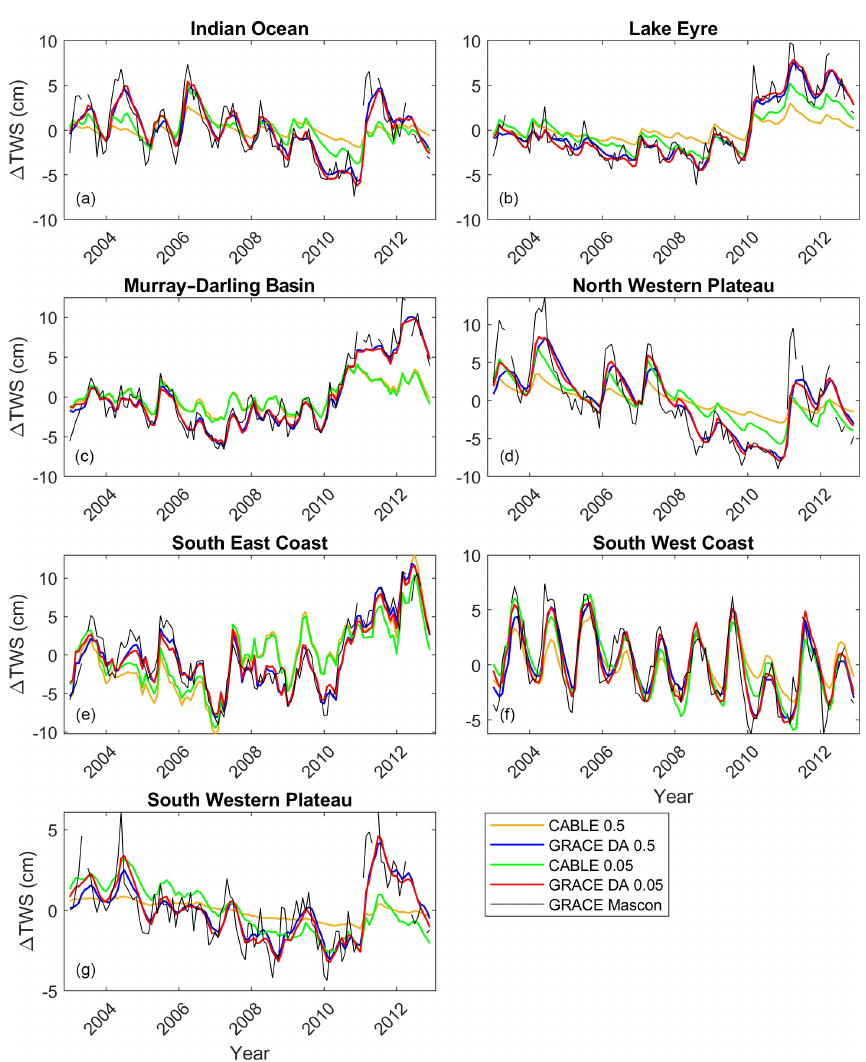
Figure 12. The TWS estimates from case studies CABLE 0.5 ◦ , CABLE 0.05 ◦ , GRACE DA 0.5 ◦ , and GRACE DA 0.05 ◦ in various river basins between 2003 and 2012. The GRACE observation is also displayed for comparison. Full descriptions of the case studies are given in Sect.